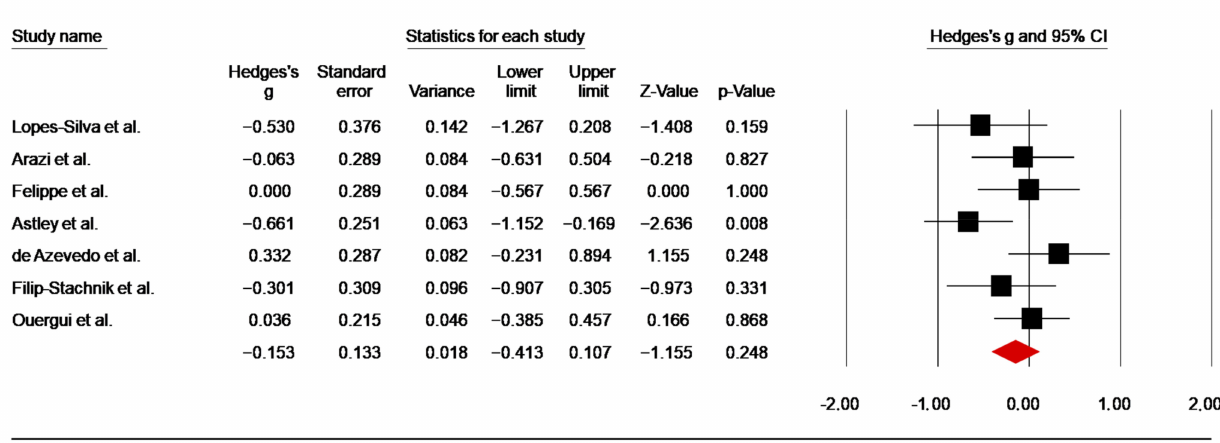
Figure 12. Forest plot of the total effect size of caffeine intake on RPE post-anaerobic exercise [45,51,52,58,65,68,69].